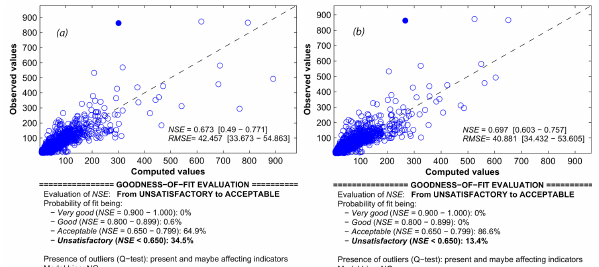
Figure 4. Goodness-of-fit evaluation for validation period (1986– 1990) at the Upper Campbell watershed: (a) UBCANN method and (b) UBCCLA